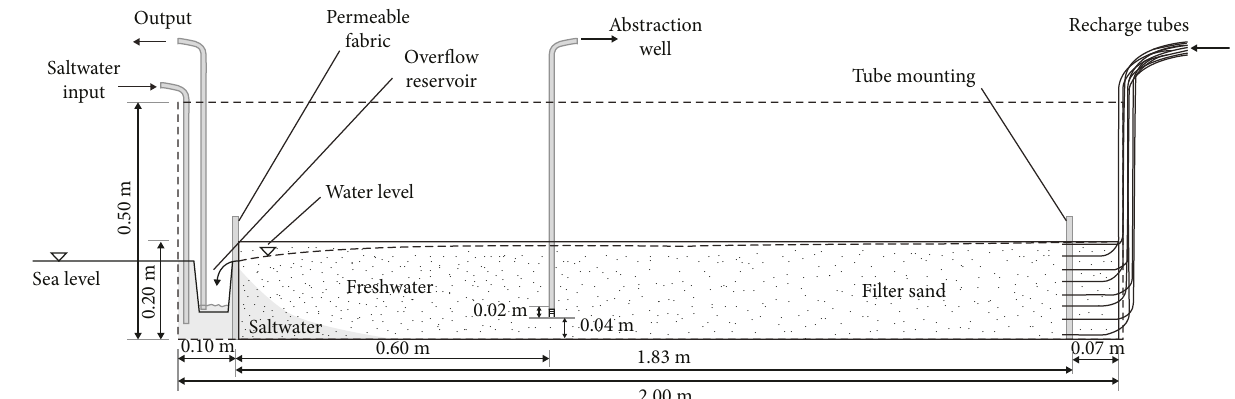
Figure 1: Schematic diagram of the physical